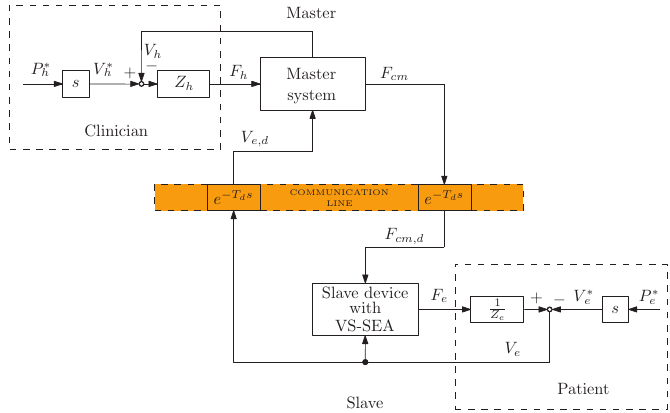
Figure 5. The teleoperation control system architecture.